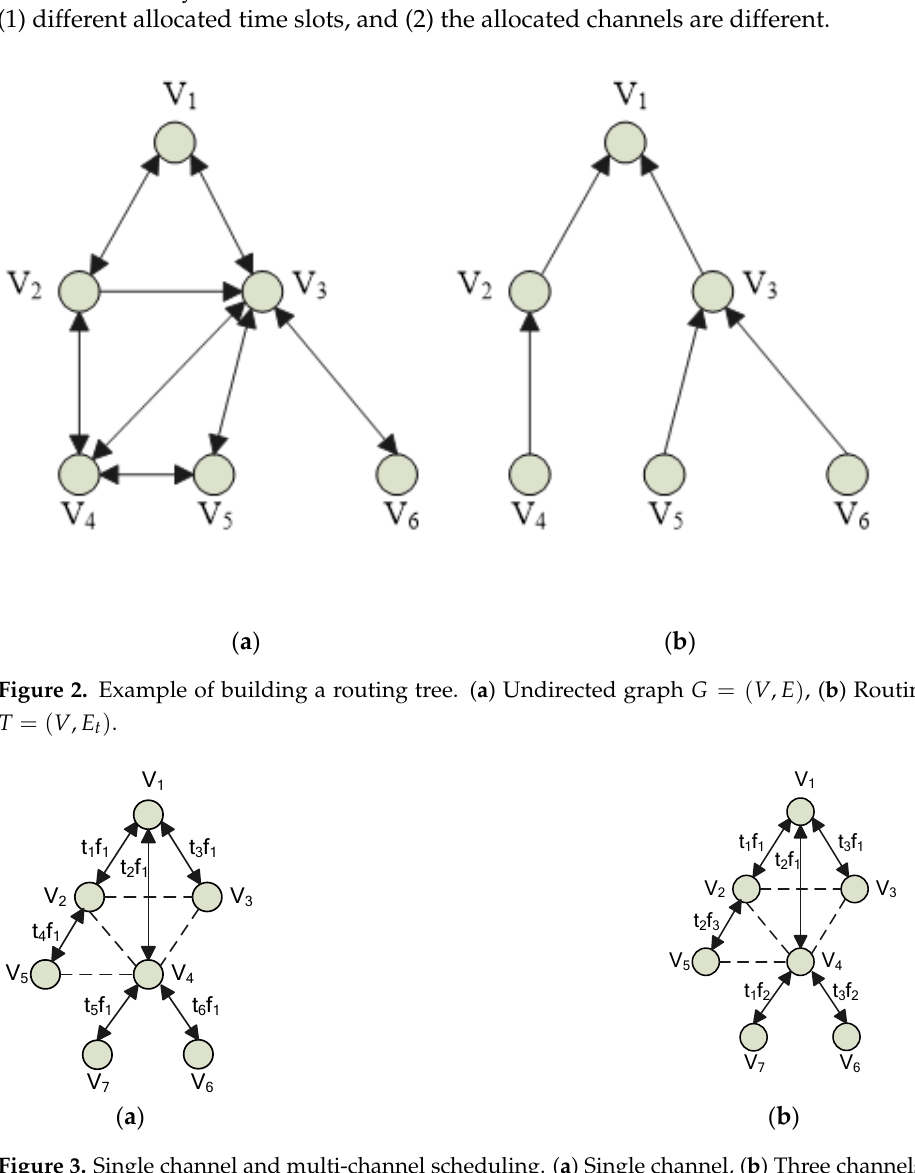
Figure 3. Single channel and multi-channel scheduling. ( a ) Single channel, ( b ) Three channels.